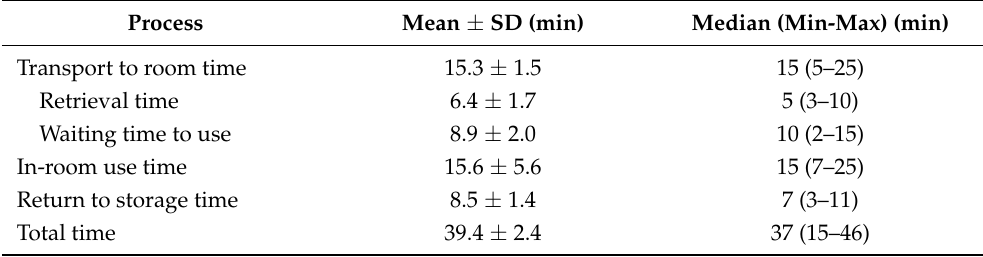
Table 3. Time for PX-UV device